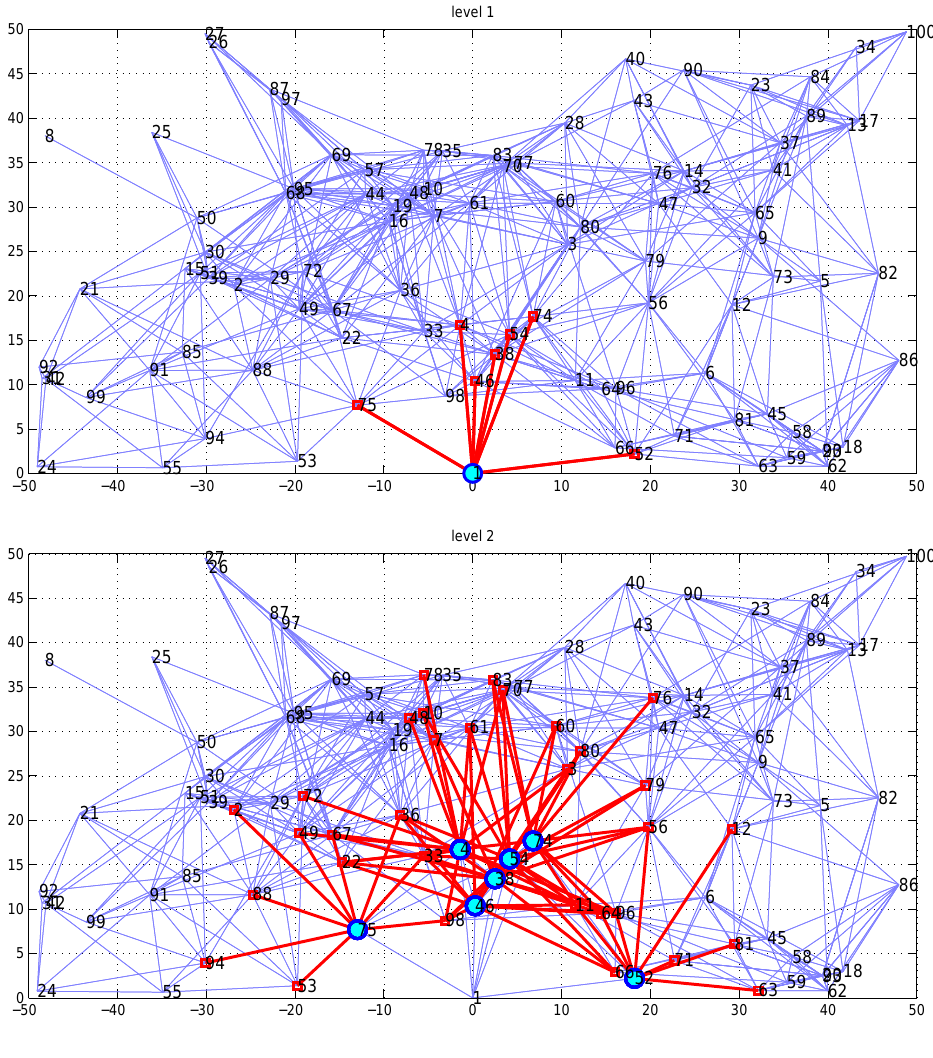
Figure 3. The resulting clustering architecture for a sample network of 100